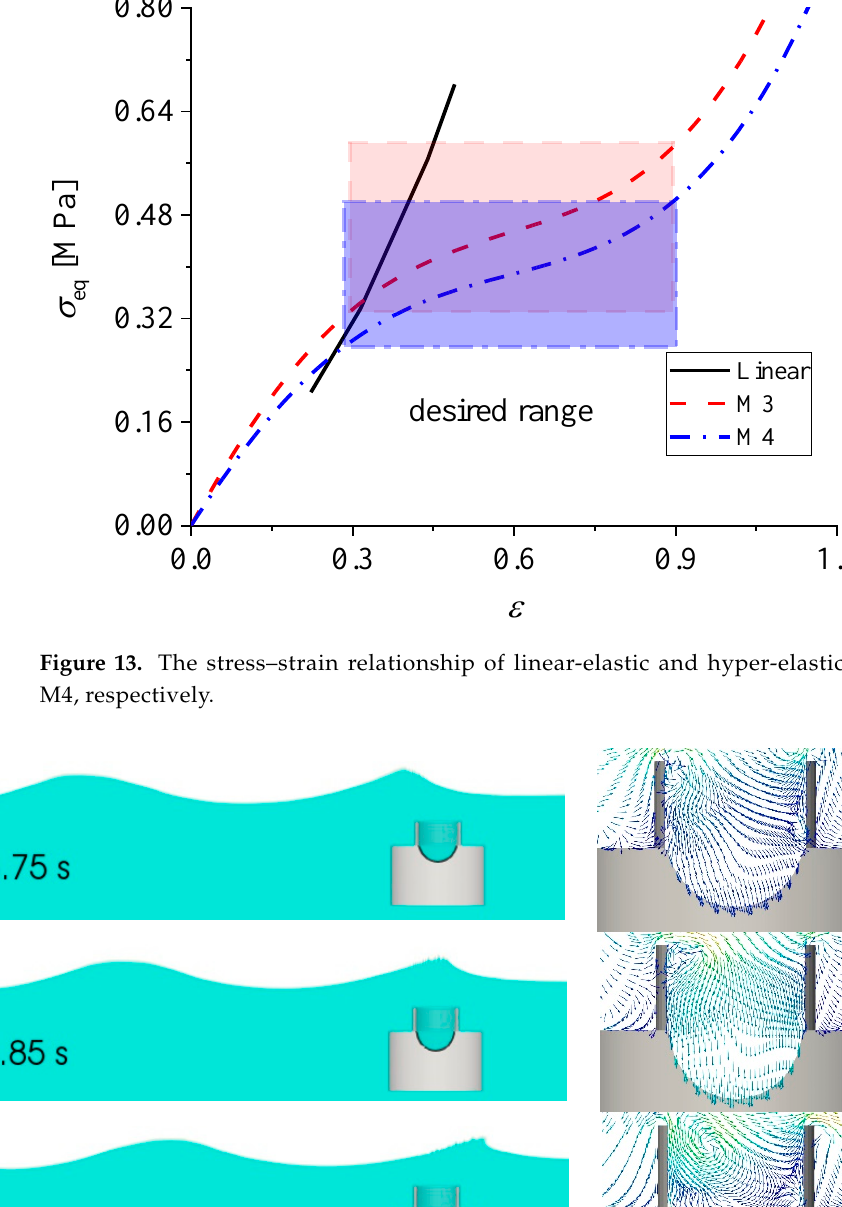
Figure 13. The stress–strain relationship of linear-elastic and hyper-elastic models M3 and M4, respectively.